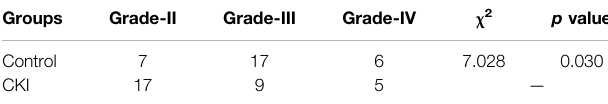
TABLE 1 | Radiation injury of neck skin was alleviated in CKI-treated